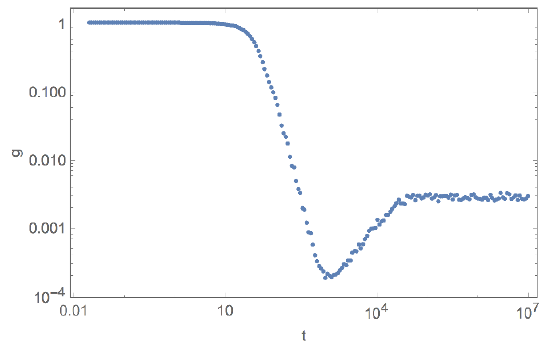
Figure 2. The Spectral Form Factor (denoted g in [37]) with N = 42 Majorana fermions and (cid:12) = 50, using the same data as in (cid:12)gure